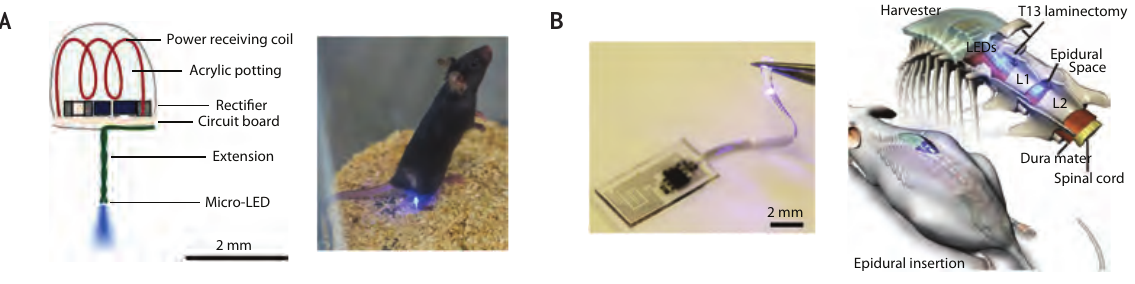
Fig. 10. Wireless LEDs for optogenetics. (A) Left: Schematic of completely implantable micro-LED system. Right: Mouse with subcutaneously implanted micro-LED for stimulation of peripheral nerve endings. Reprinted by permission from [176], Copyright 2015, Macmillan Publishers Ltd. (B) Left: Picture of a soft optoelectronic system including the harvester component and the soft, stretchable connector to an LED. Right: Schematic of implantation of device into the epidural space for spinal illumination. Reprinted by permission from [165], Copyright 2015, Macmillan Publishers